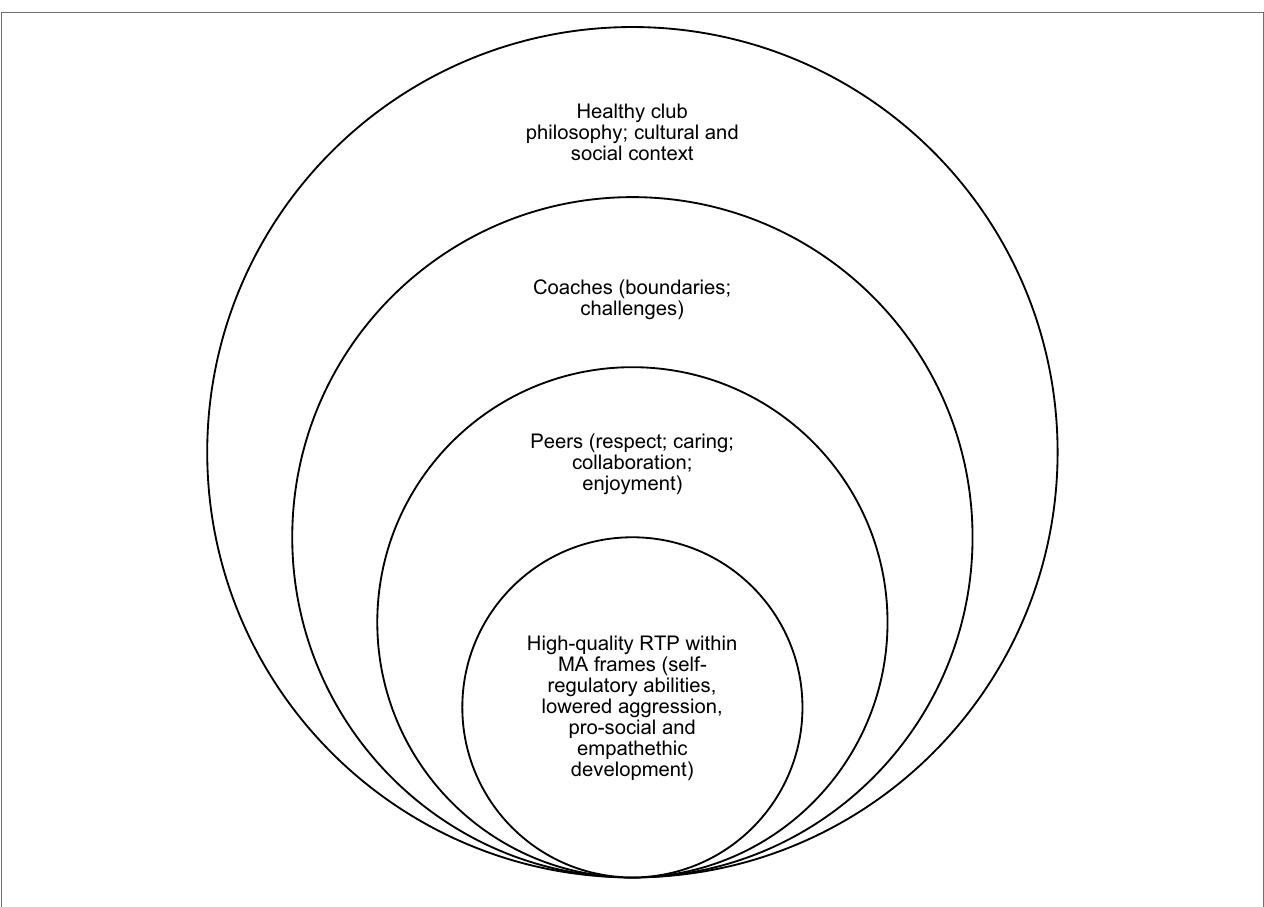
FIGURE 1 | An ecological model of high-quality RTP within